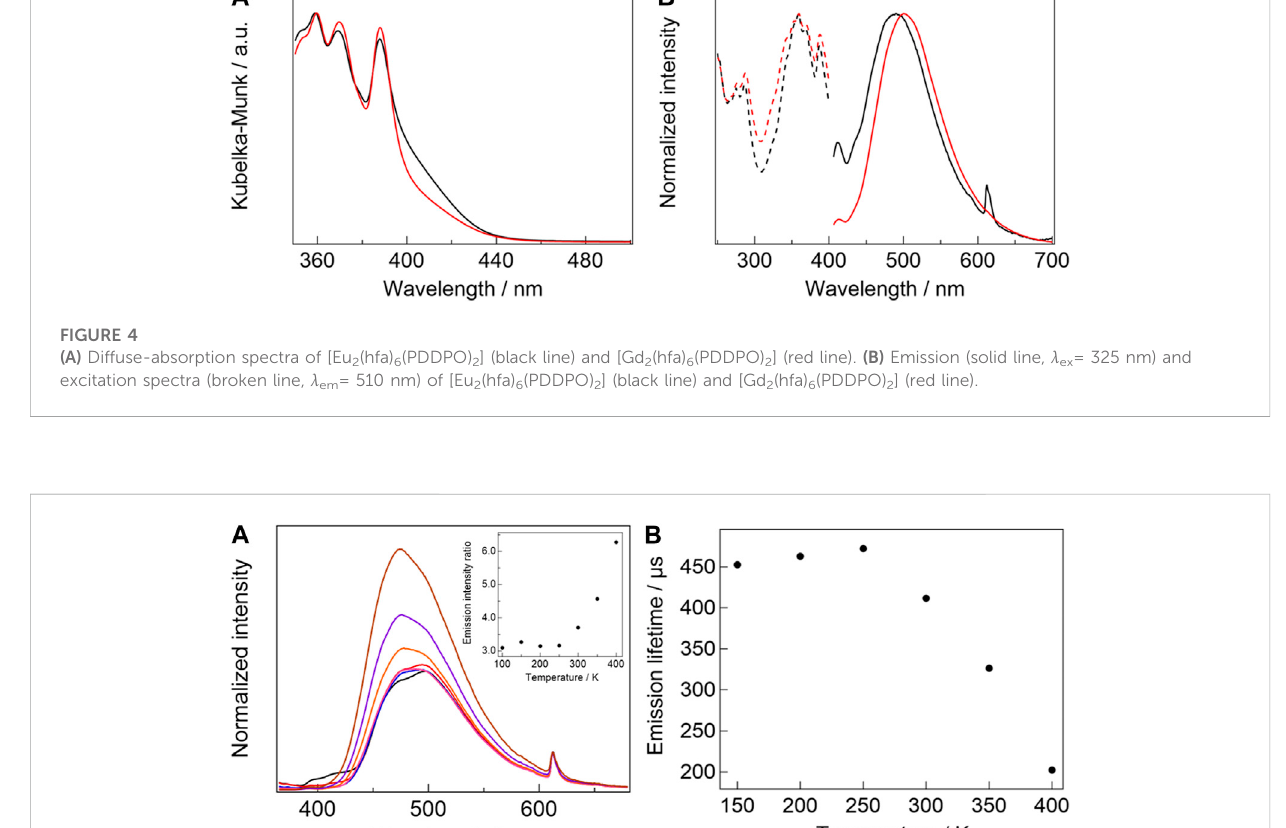
energy transfer from PDDPO to Eu(III) ( 5 D 0 : 17,200 cm -1 ) (Bao et al., 2018). According to a previous report, hfa (S 1 = 24,000 cm -